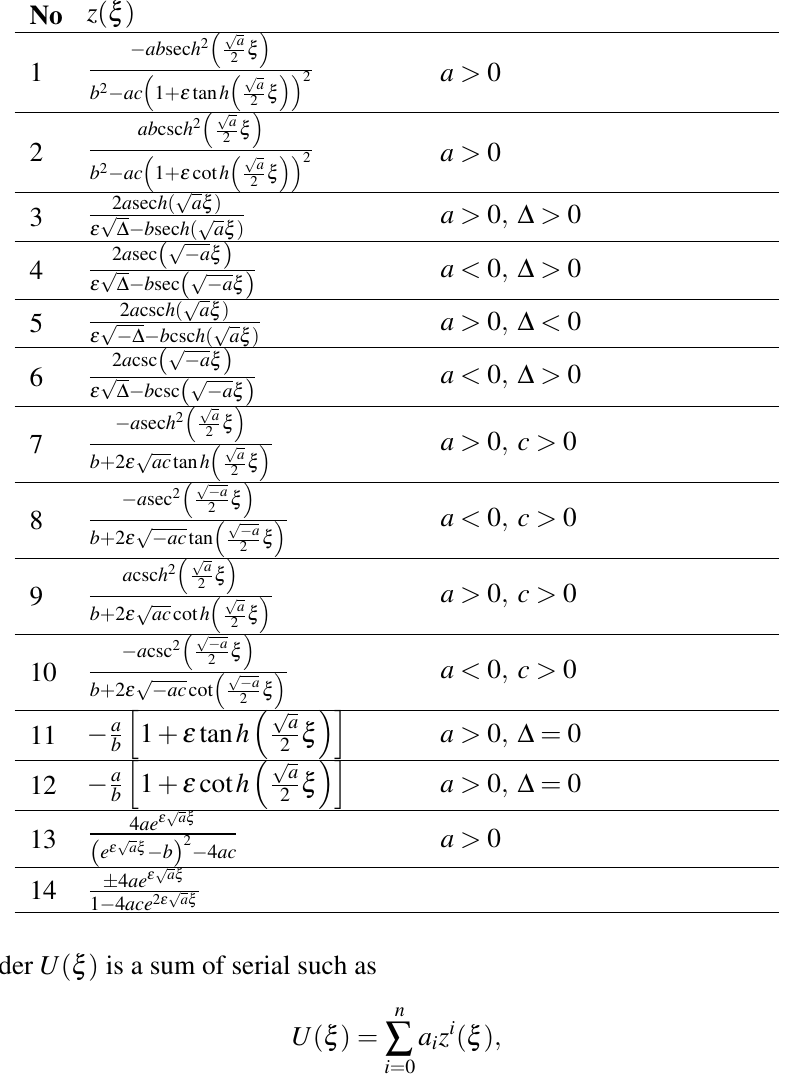
Table 1 Solutions of Eq. (4) with ∆ = b 2 − 4 ac and ε = ±